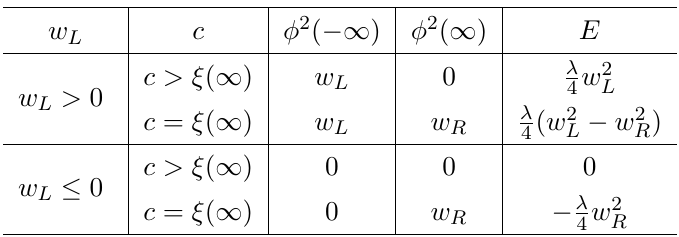
Table 1 . Asymptotic values and energies of the non-constant solution (4.8) in deformed φ 6 theory. In addition, there is a constant solution φ = 0 with E = 0